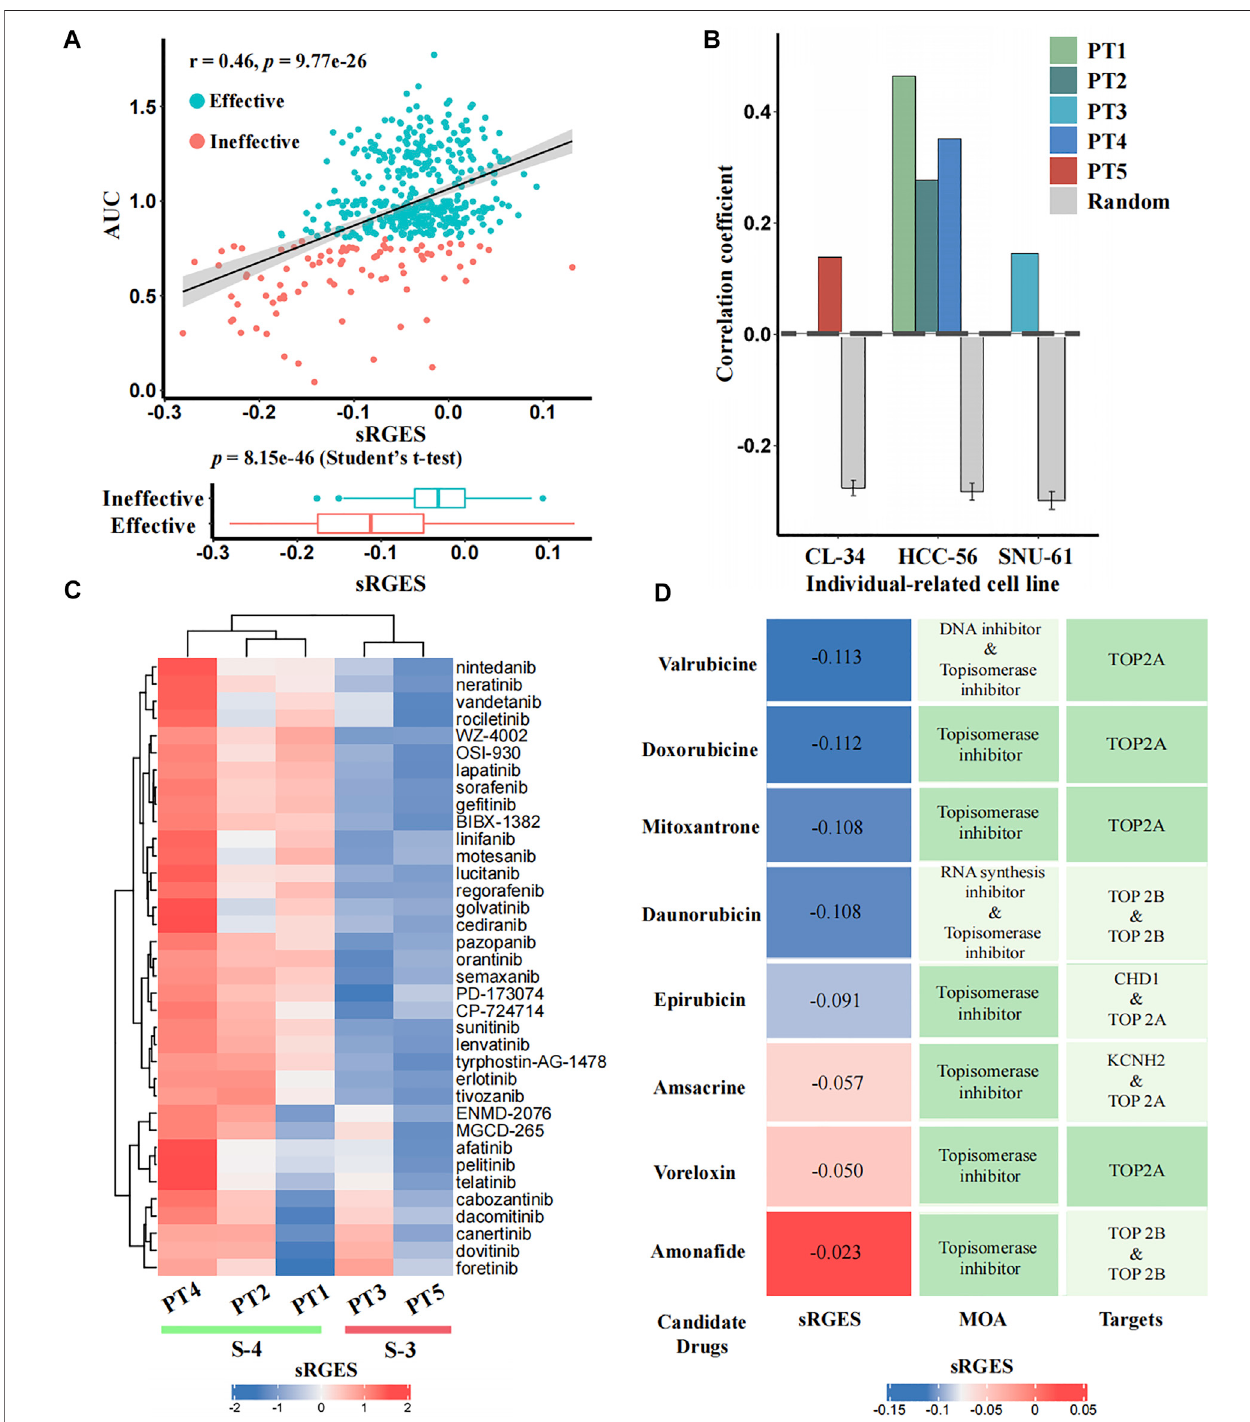
FIGURE 4 | In silico estimation of the effectiveness of predicted drugs. (A) Correlation analysis between sRGES scores and ef fi cacy AUCs of the predicted drugs (the top panel) and differential analysis ( t -test) of sRGES scores between effective and ineffective drugs (the bottom panel) on PT1-relevant cell line. The y -axis of the top panel represents the median AUC of multiple treatments of a drug on this cell line. See Supplementary Figure S3 for results of other four patients. (B) Comparison results of the correlation coef fi cients between fi ve patients and null distributions. The x -axis represents the individual-related cell lines of the fi ve patients, and the y -axisrepresentsthePearsoncorrelationcoef fi cientsbetweensRGESscoresanddrugef fi cacyAUCs. (C) sRGESscoresofEGFRandVEGFRinhibitorsof fi vepatients. (D) Predicted topoisomerase inhibitors for PT1 and the corresponding sRGES scores, MOA, and target annotations.